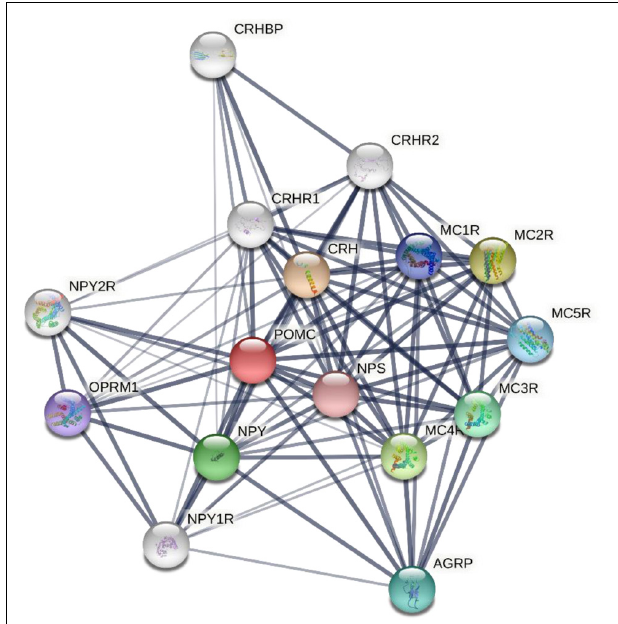
FIGURE 3 | Protein-protein interactions network involving human melanocortin system and other key proteins as revealed by the STRING (Search Tool for the Retrieval of Interacting Genes/Proteins), a biological database and web resource of known and predicted protein–protein interactions. The associations between key proteins are indicated by the connecting lines. The thickness of the connecting lines represents the strength of the associations. The associations do not necessarily suggest that the proteins are physically binding each other, but may jointly contribute to a shared function. The analysis was performed using STRING V11.0 (STRING https://string-db.org/). CRH, corticotropin releasing hormone; NPY, neuropeptide Y; NPS, neuropeptide S; AGRP, agouti related protein homolog; OPRM1, mu-type opioid receptor; CRHBP, corticotropin-releasing factor-binding protein; MCR, melanocortin